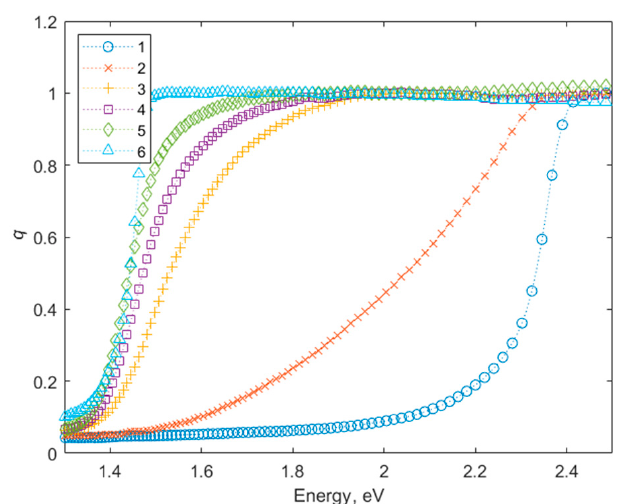
Figure 4. Normalized, experimental PA amplitude spectra for CdS 1 − x Te x samples. 1: x = 0; 2: x = 0.016; 3: x = 0.05; 4: x = 0.07; 5: x = 0.1; 6: x = 1.